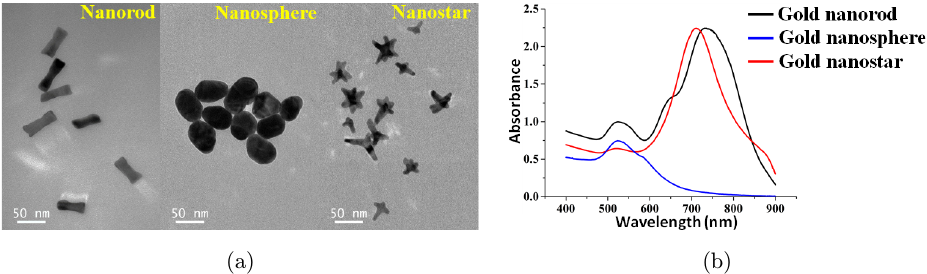
Fig. 3. Characterization of gold nanoparticle based substrates with di®erent morphologies. (a) TEM images of gold nanorods, nanospheres and nanostars with a similar diameter. (b) The UV – Vis spectrum of the substrates with a nearly identical gold nanoparticle concentration ð 5 : 8 (cid:1) 10 (cid:2) 10